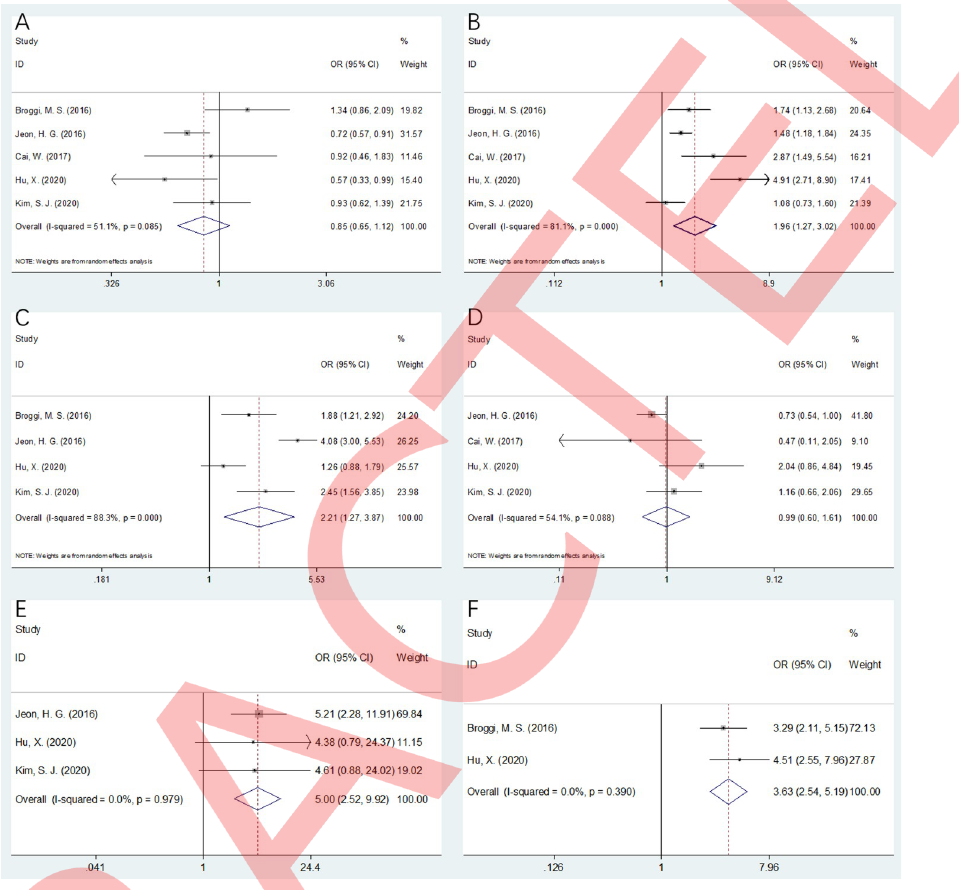
Fig 5. Forest plot of PNI with clinicopathological features in patients with renal cell carcinoma. (A) sex (male vs female); (B) Fuhrman grade (III-IV vs I-II); (C) T stage (T3-T4 vs T1-T2); (D) histology (ccRCC vs non-ccRCC); (E) sarcomatoid differentiation (yes vs no); (F) tumor necrosis (yes vs no).